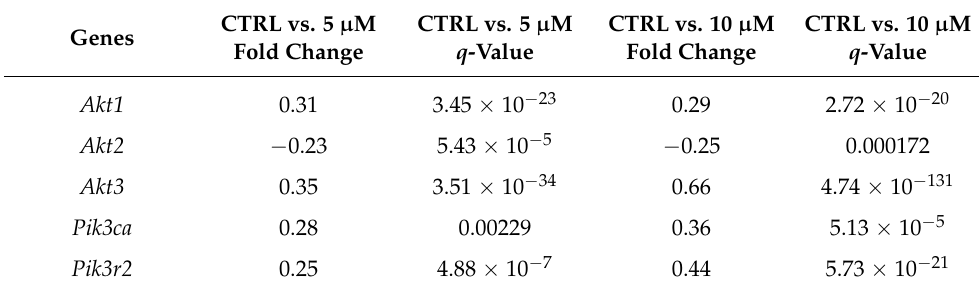
Table 5. DEGs of MCM and the genes involved in the PI3K/AKT pathway.